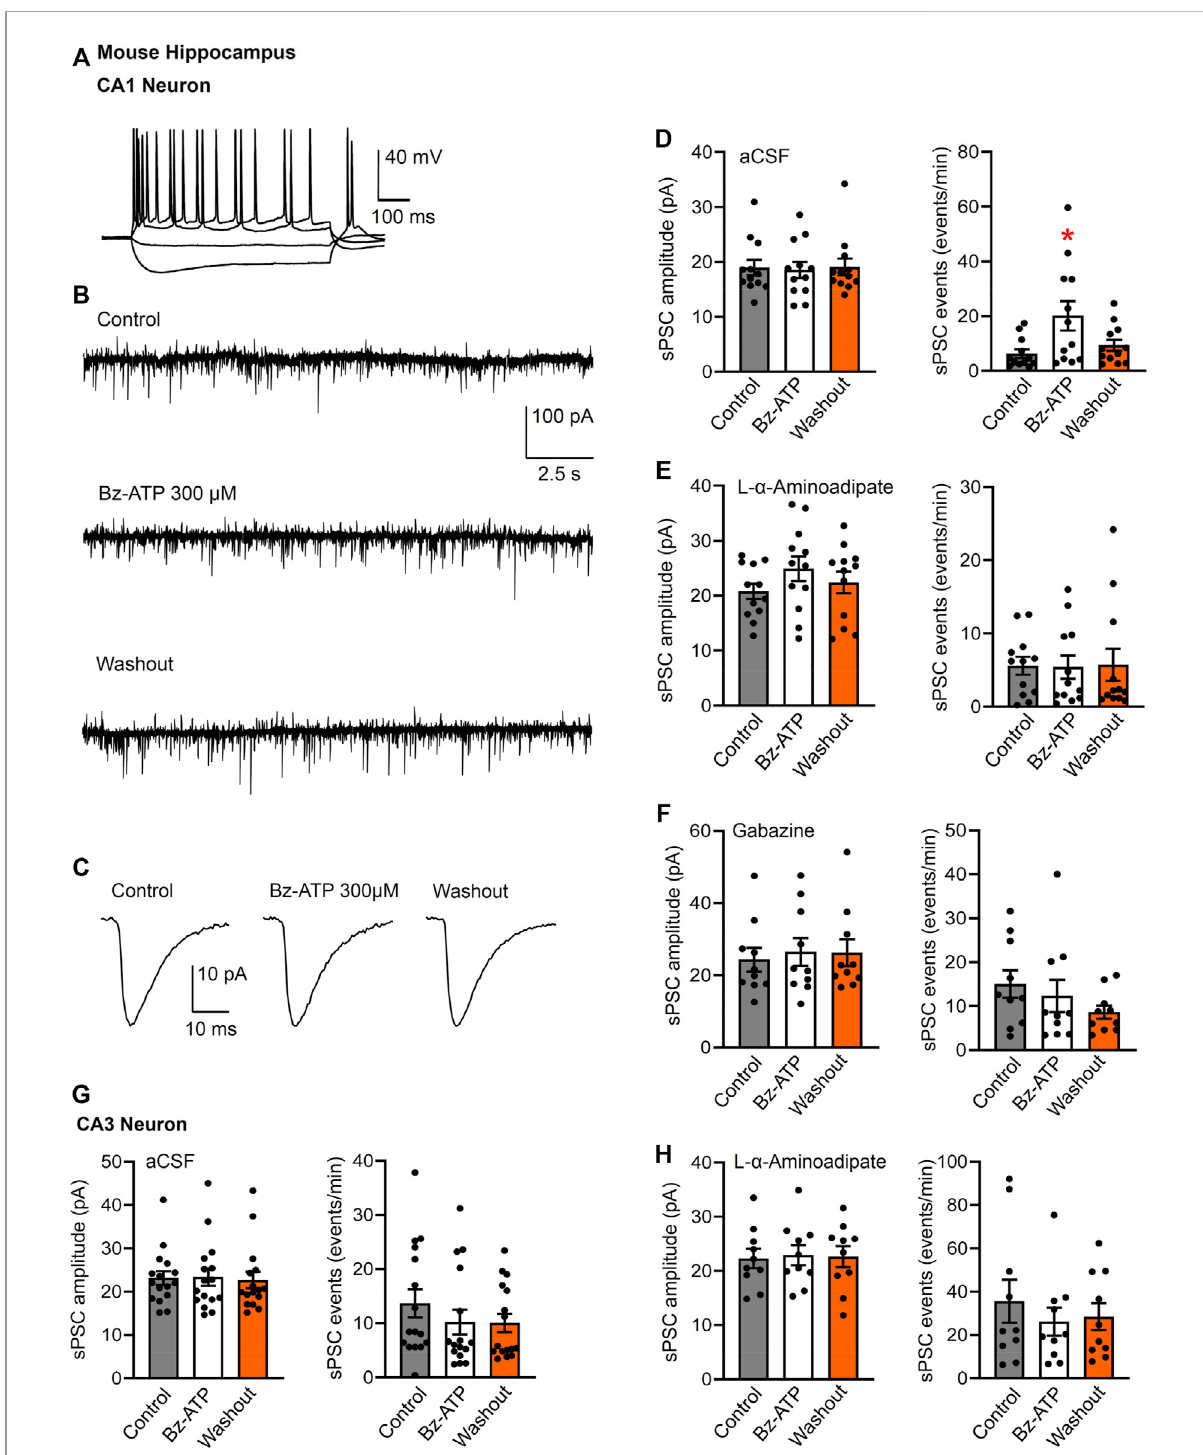
FIGURE 5 Spontaneouspostsynapticcurrents(sPSCs)inCA1andCA3neuronsinbrainslicesofmice;effectsofBz-ATPafterorwithoutL- α -aminoadipate pre-treatment. (A) Identi fi cation of CA1 neurons by current injection into whole-cell patch-clamped cells. (B – D) Effect of Bz-ATP (300 µM) on the amplitude and frequency of sPSCs in a low X 2+ -containing aCSF. Representative recordings of sPSCs before, during and after superfusion with Bz-ATP for 5 min (B) . Representative, averaged sPSC amplitudes before, during and after a 5-min superfusion with Bz-ATP (C) . (D) Mean ± SEM sPSC amplitudes and frequencies in brain slices prepared from untreated mice. * p < 0.05; statistically signi fi cant difference from control